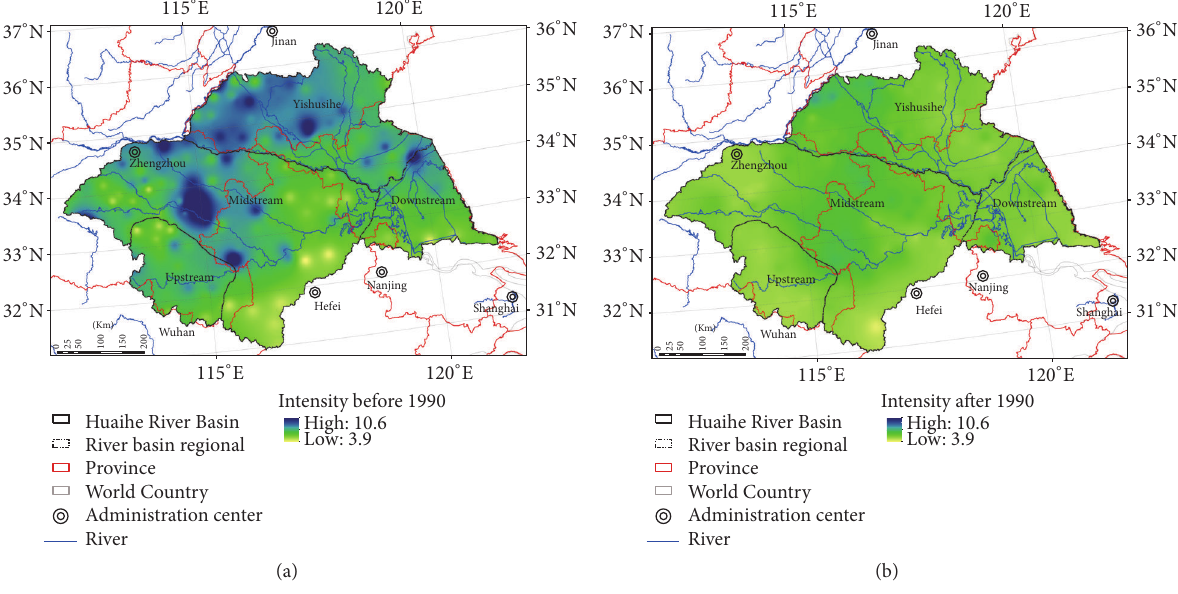
Figure 13: Spatial distribution of isolated rainstorm event intensity, before and after mutation